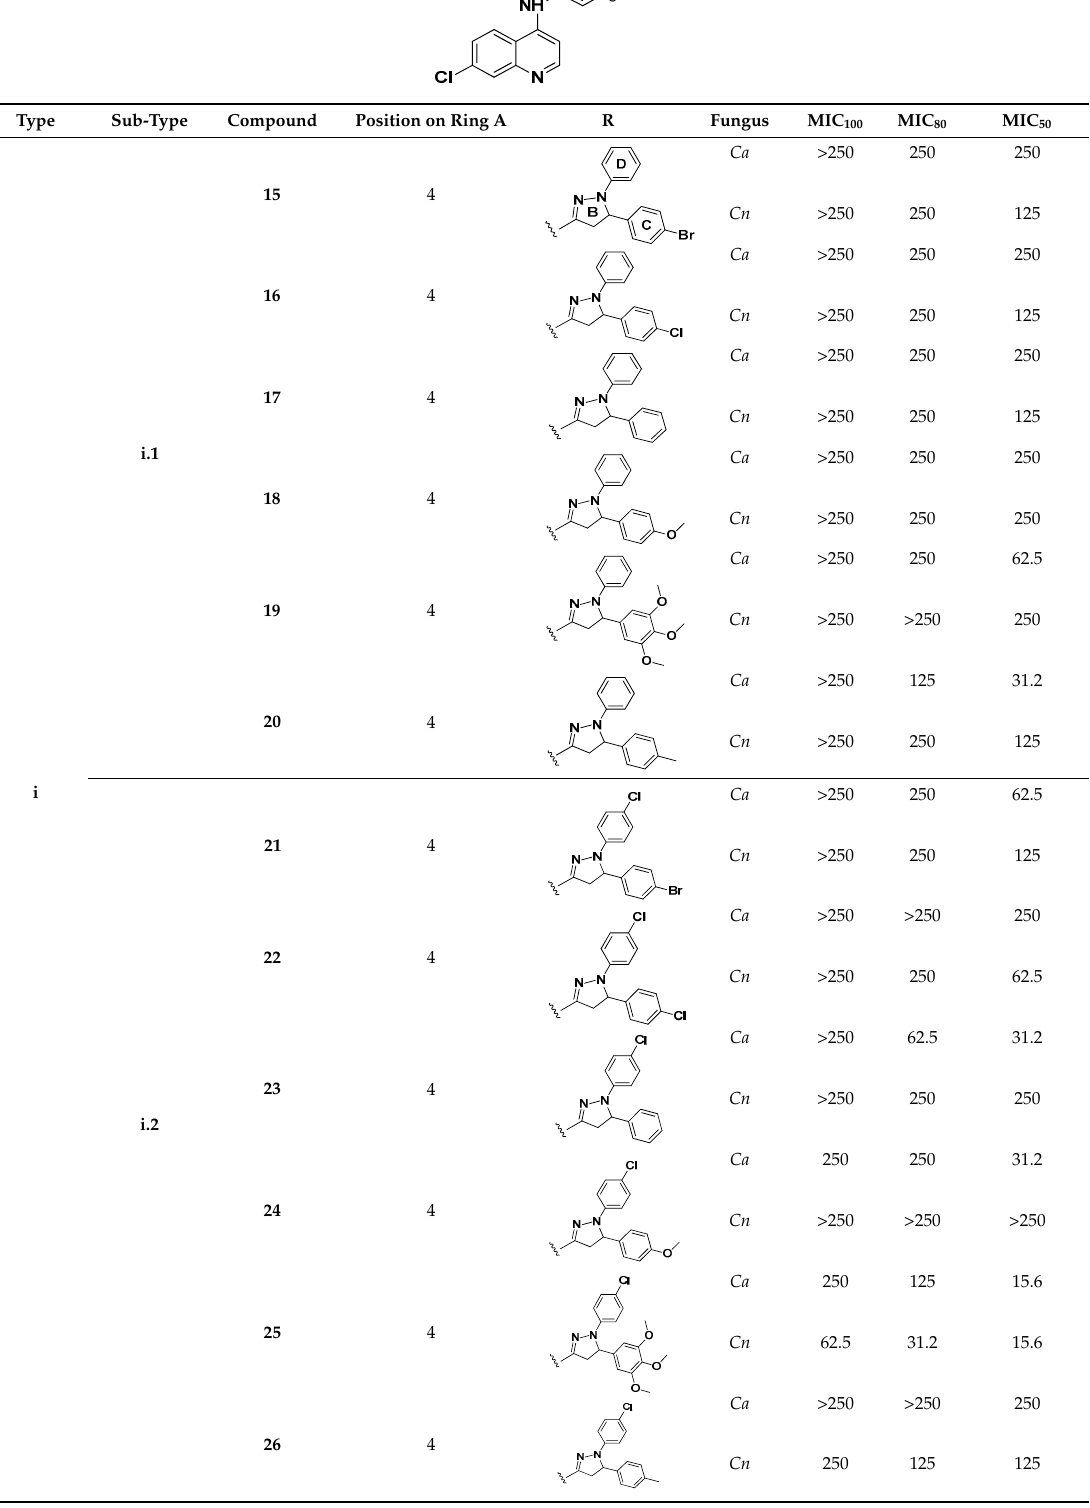
Table 3. Antifungal activity (MIC 100 , MIC 80 , MIC 50 values) obtained for compounds 15 – 38 against the fungi Candida albicans and Cryptococcus neoformans.